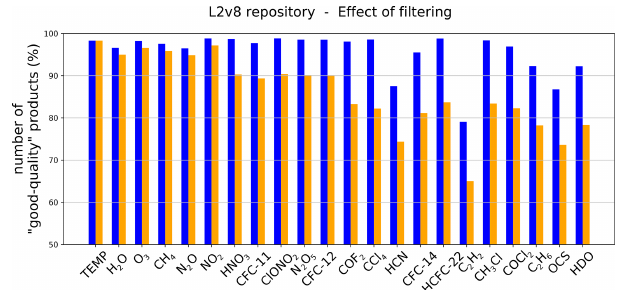
Figure 6. Blue bars: percentage of “good” profiles with respect to the profiles of the trace species contained in the MIPAS level2-v8 database; orange bars: percentage of “good” profiles with respect to all the temperature profiles contained in the MIPAS level2-v8